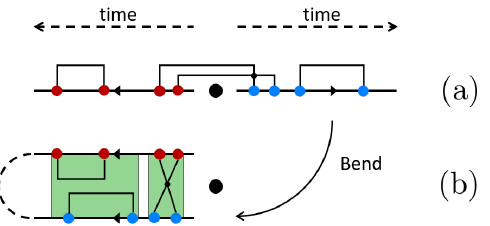
Figure 5: Two equivalent ways of drawing Keldysh real-time diagrams. (a) Nonstan- dard left-right form: Time runs outward from the center. This is useful for identifying the operator-sum form of the real-time expansion, cf. Fig. 6. (b) Standard forward- backward form, obtained by bending the right branch in (a) backward: Time runs from right to left to agree with the order of writing expressions. This form is advan- tageous for identifying the diagrammatically irreducible components (green) of the time-evolution in Sec. 4. For fermions, the sign of the contribution of a diagram is given by ( − 1 ) n c where n is the number of crossings of the environment contraction c lines, which is the same for (a) and (b). We note that it is common to denote the ad- joint U † ( t ) = U ( − t ) the ‘backward’ evolution, imagining to traverse the contour first forward along the upper branch, then across the dashed connector ‘backward’ on the lower branch. Here, this is misleading: Time always runs in the forward direction, also on the lower contour as indicated in